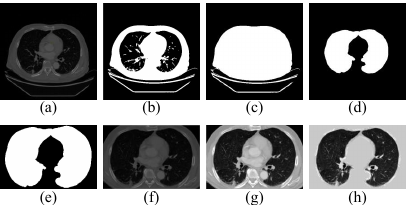
Figure 4. The procedure of preprocessing for raw LDCT